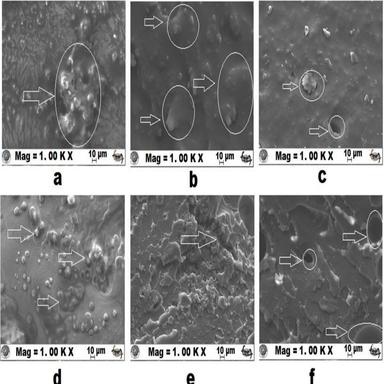
SEM images of: a–c) DGEBA/CNT composites; d–f) EPN/CNT composites at 1.0, 1.5 and 2.0 wt% of filler.